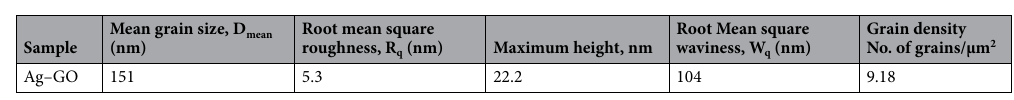
Table 2. Grain size, roughness and grain